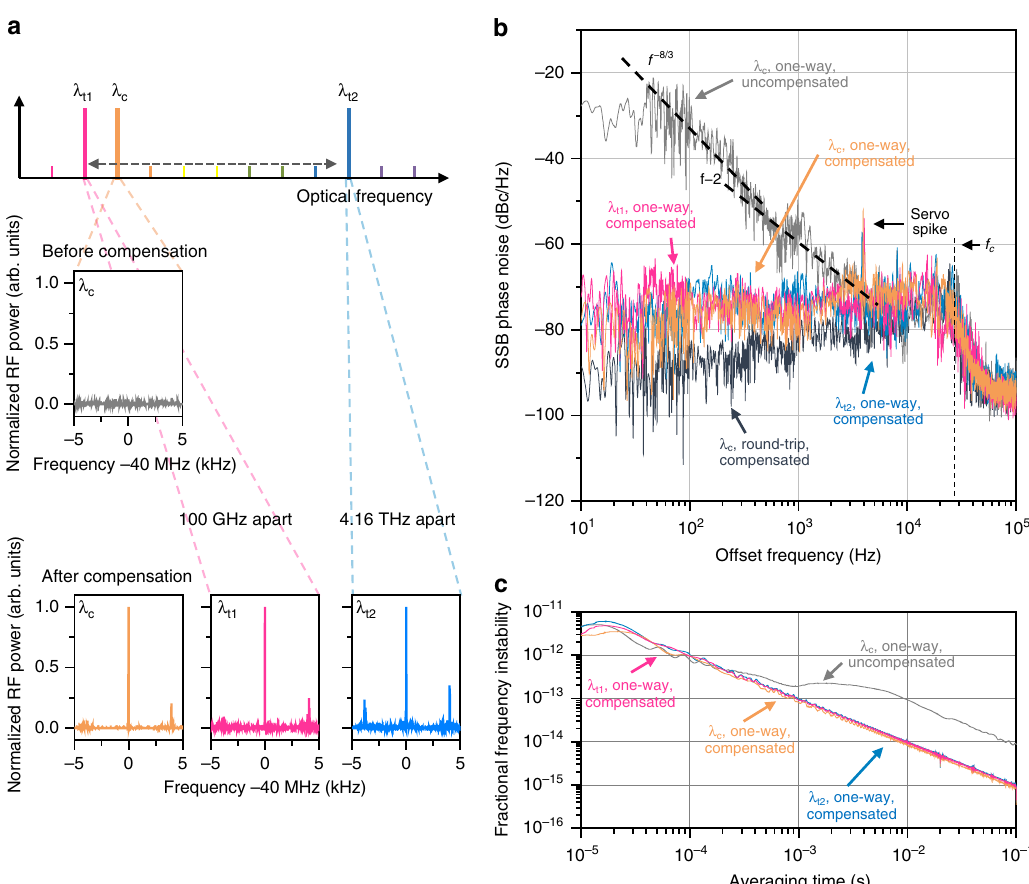
Fig. 3 Coherent transfer of optical frequencies over an 18-km free-space link. a RF beats of comb-rooted carriers with original carrier signals monitored before and after phase noise compensation. b Single side band (SSB) phase noise spectra of one-way (form Site A to Site B) and round-trip (Site A – Site B – Site A) optical carriers. f c denotes the control bandwidth of phase noise compensation. c Allan deviation of one-way optical carriers after phase